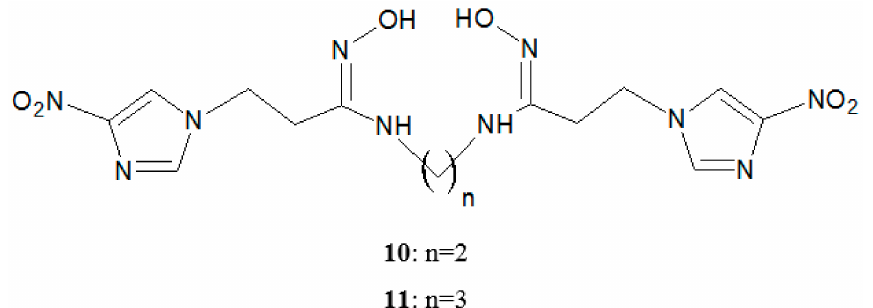
Figure 5. Structure of tetradentate ligands ( 10 , 11